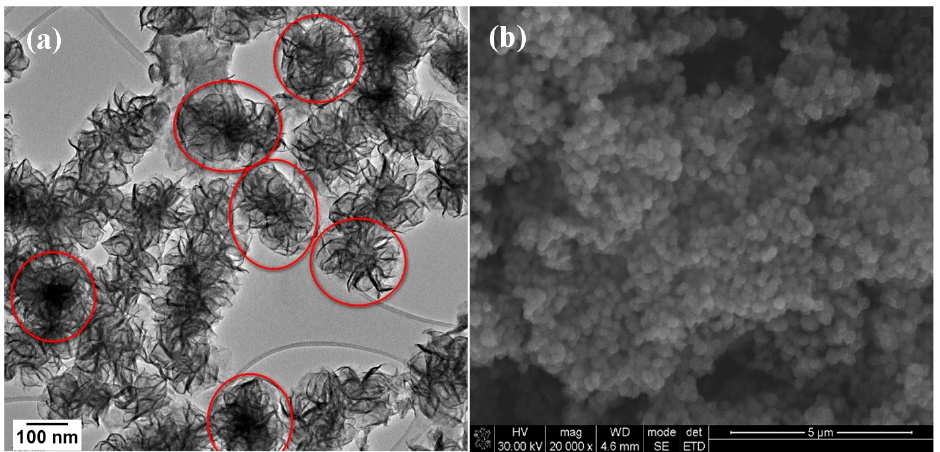
Figure 5. ( a ) TEM and ( b ) SEM images of MoSe 2 nanoflowers formed at 30 min reaction time.